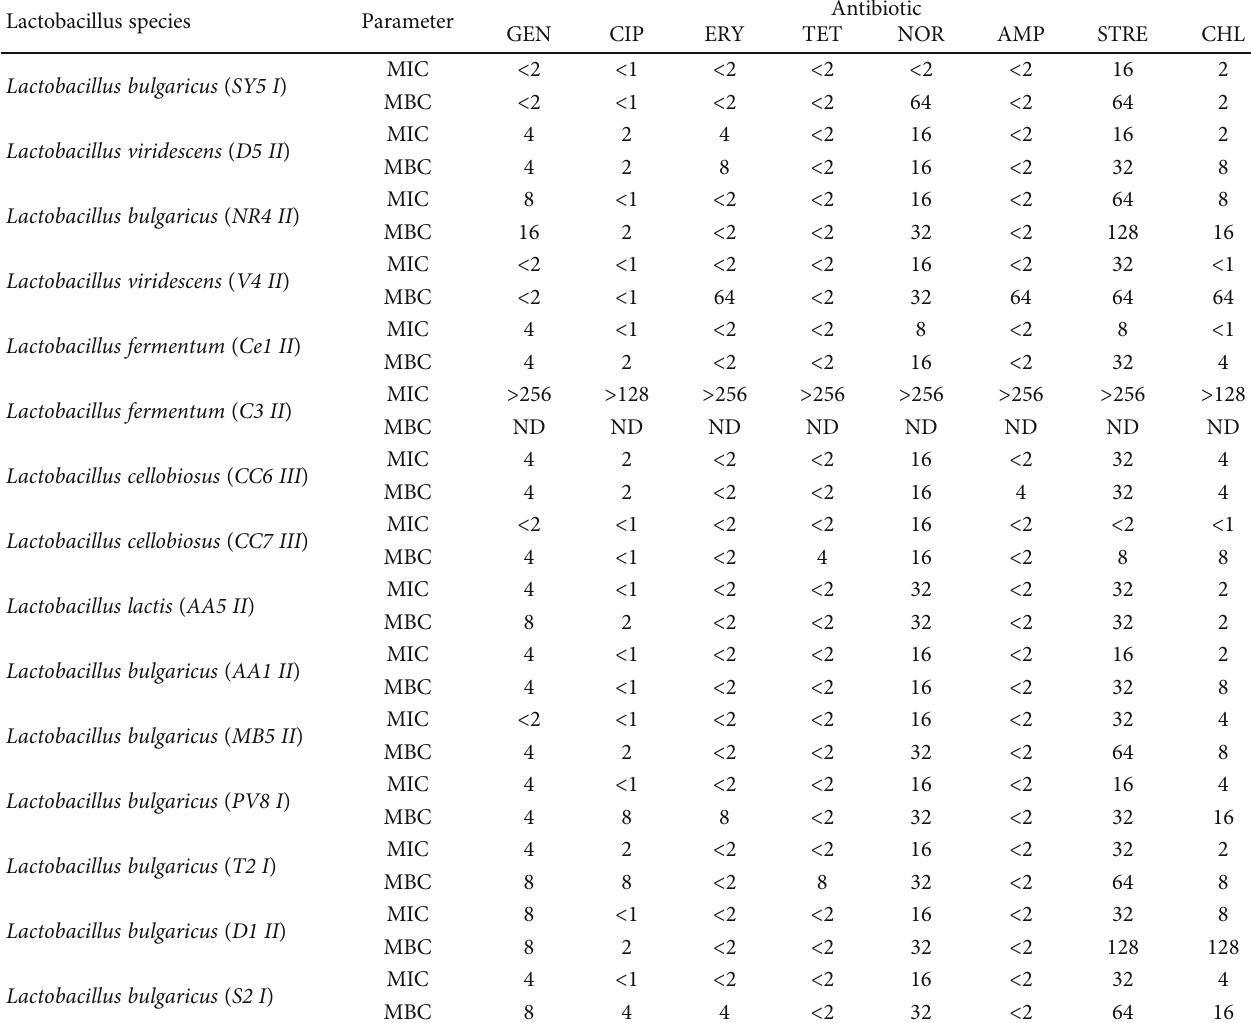
Table 7: The susceptibility of lactobacillus species to some conventional antibiotics. Lactobacillus species